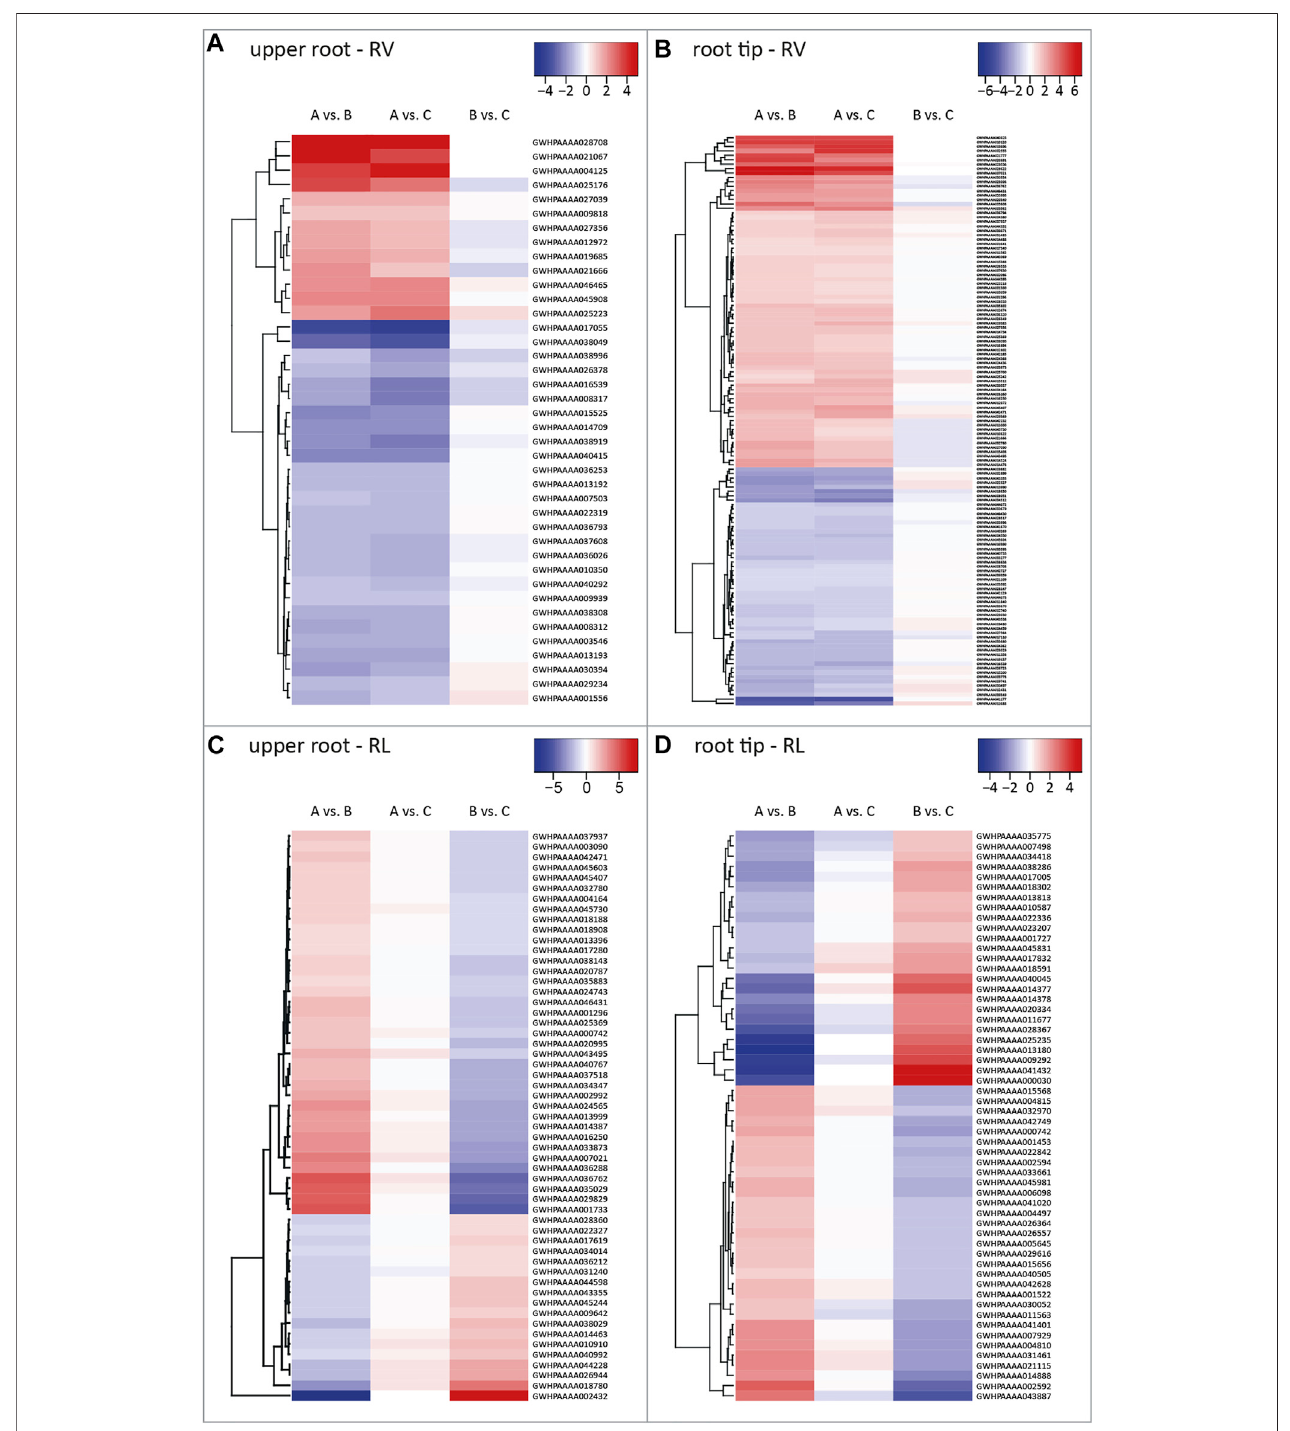
FIGURE 3 | Heat maps of root volume (RV) and root length (RL) candidate genes. Heat maps visualizing all RV and RL candidate genes identi fi ed in different root parts with their corresponding log2 fold change values for pairwise comparisons among the three plant pools. Each row depicts the log2 fold change values of the comparisons with blue, white and red boxes representing negative, close-to-zero and positive values, as indicated by the corresponding scale bars. Shown are RV candidate genes identi fi ed in (A) the upper root and (B) the root tip, as well as RL candidate genes identi fi ed in (C) the upper root, and (D) the root tip. Each row shows log2 fold change values of pairwise comparisons between the plant pools. Pool A (cid:1) plants with medium to long and thick roots (high value for primary root length andvolumeintheupper5 cmoftheprimaryroot).PoolB (cid:1) plantswithshort,thinroots.PoolC (cid:1) Plantswithlong,thinroots.RV (cid:1) DEGsin fl uencingprimaryrootvolume. RL (cid:1) DEGs in fl uencing primary root